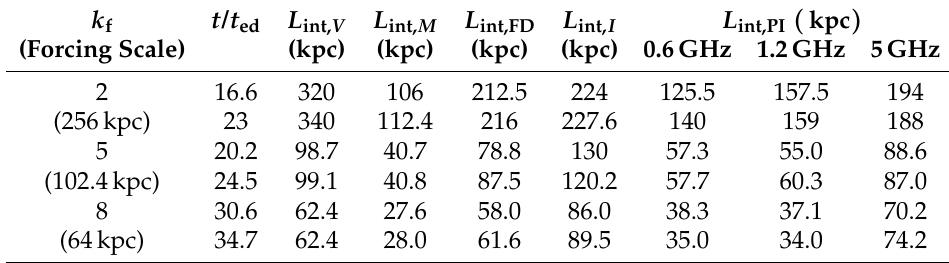
Table 3. Values of the integral scales (in kpc) of the velocity ( L int, V ), magnetic fields ( L int, M ), Faraday depth ( L int,FD ), the total synchrotron intensity ( L int, I ) at 1 GHz, and, the polarized intensity ( L int, PI ) at 0.6, 1.2 and 5 GHz at two different times in the steady state obtained from three simulations where turbulence is driven on scales of l f = 256,102.4 and 64